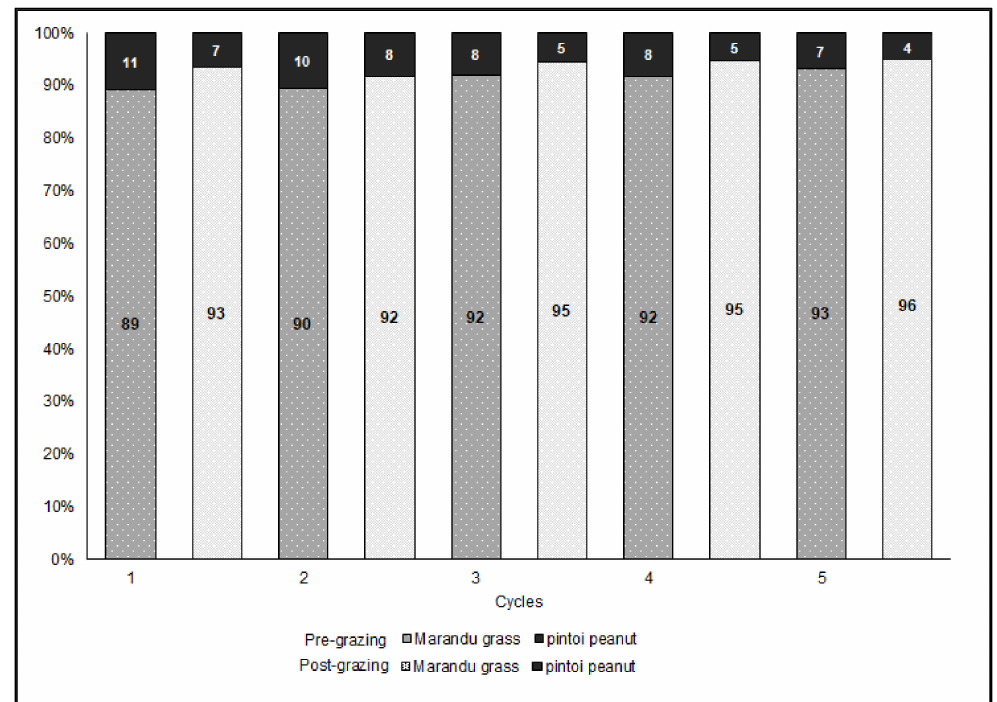
Figure 2. Botanical composition of palisade grass mixed with pintoi peanut in pre- and post-grazing conditions.